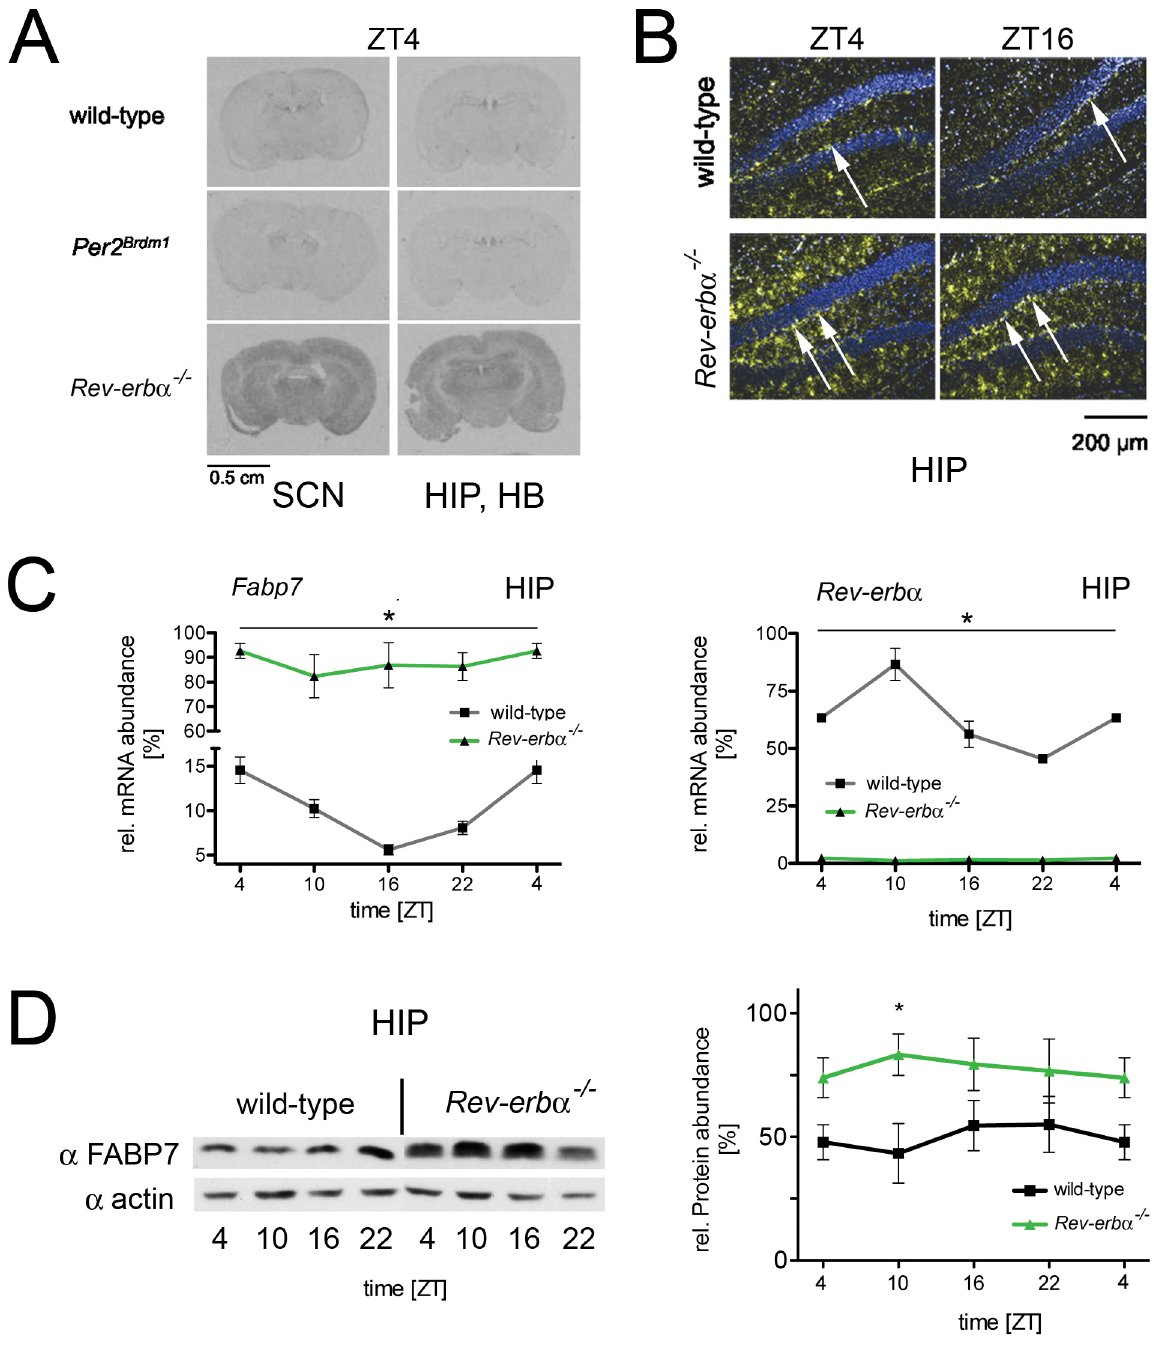
Figure 2. Expression profile of Fabp7 mRNA and protein in brain tissue. ( A ) In situ hybridization on coronal brain sections of wild-type, Per2 Brdm1 , and Rev-erb a 2 / 2 mice at ZT4. The sections in the left column contain the SCN, the sections in right column the hippocampus (HIP) and habenula (HB). ( B ) The panel shows dark-field microscopy of the hippocampus (HIP) in the dentate gyrus region. Blue represents Hoechst-dye stained cell nuclei and the yellow signal represents the hybridization signal detecting Fabp7 mRNA. ( C ) Quantification of Fabp7 mRNA in the hippocampus of wild-type (black) and Rev-erb a 2 / 2 mice (green) over the period of 24 hours (left panel). The right panel depicts the Rev-erb a mRNA in the hippocampus of wild-type (black) and Rev-erb a 2 / 2 mice (green). 2-way ANOVA reveals a significant difference between wild-type and Rev-erb a 2 / 2 mice (n=3, p , 0.05, mean 6 SEM). ( D ) The left panel shows a Western blot illustrating FABP7 protein levels in the hippocampus area of wild-type and Rev-erb a 2 / 2 mice. The right panel illustrates the quantification of FABP7 signal. 2-way ANOVA reveals a significant difference between wild-type and Rev-erb a 2 / 2 mice (n=3, p , 0.05, mean 6 SEM).